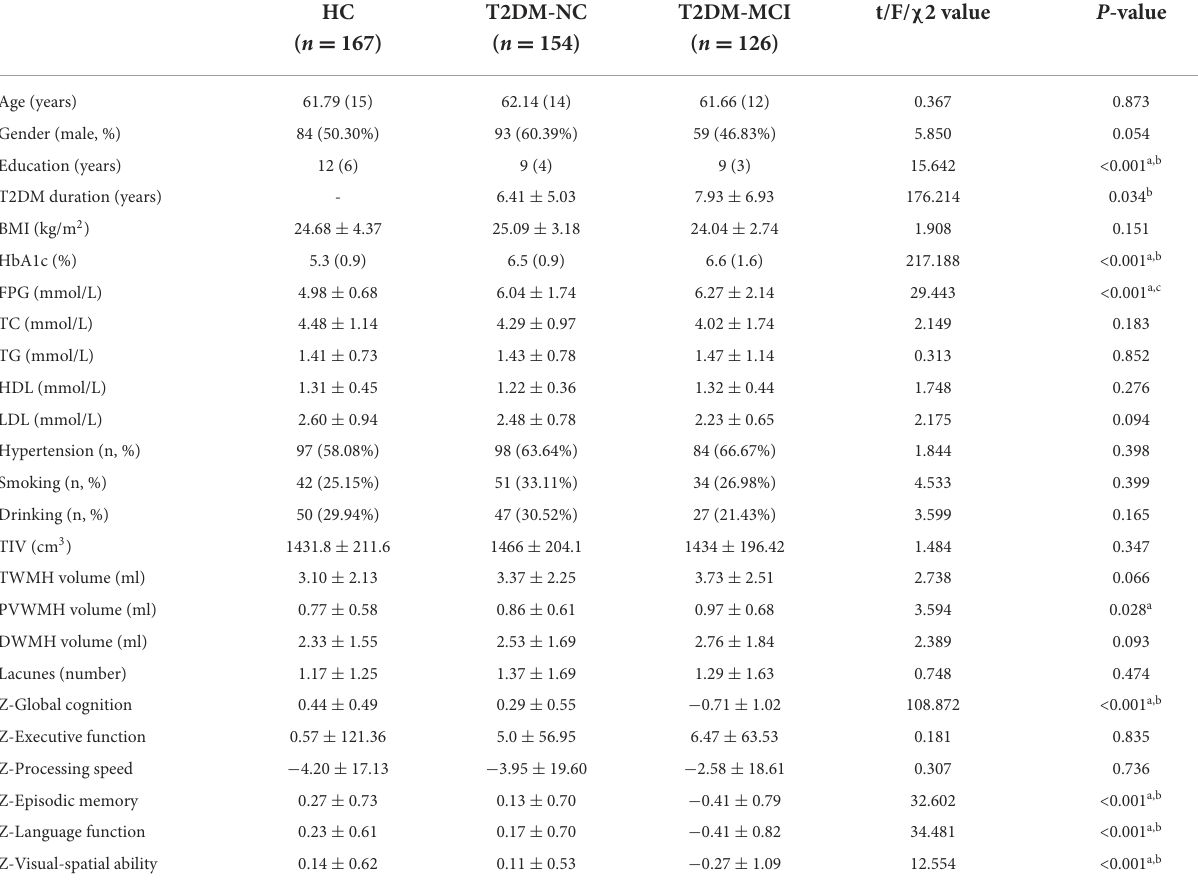
TABLE 1 Demographic, clinical, and cognitive data for participants of the three